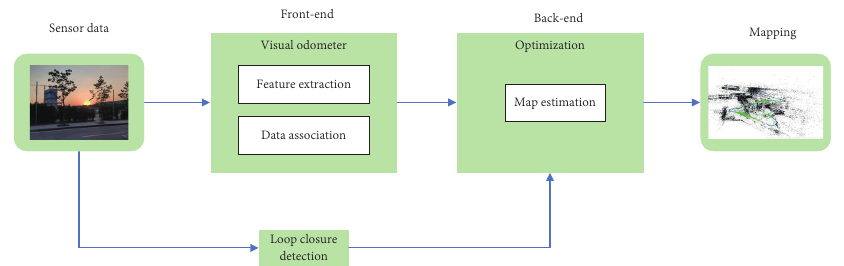
Figure 12. Classical visual SLAM